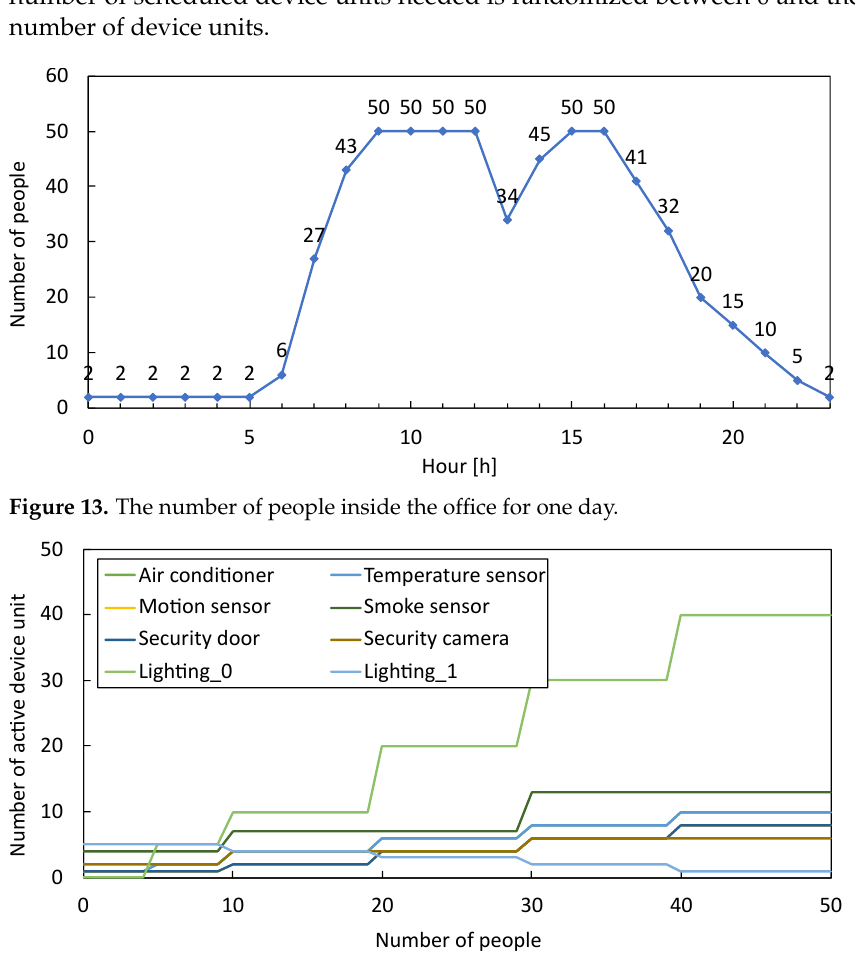
Figure 14. The number of device units activation rule based on the number of